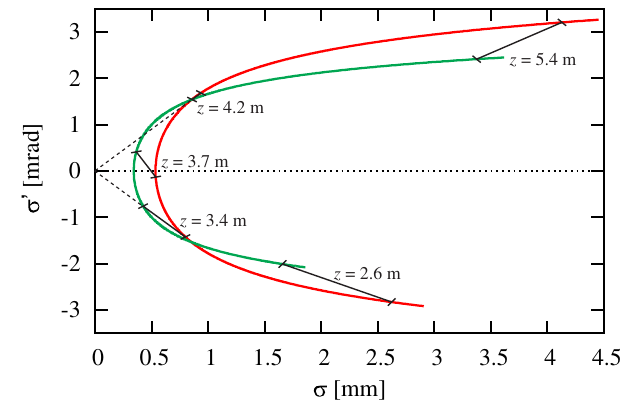
FIG. 8. Divergence versus beam size during the emittance compensation process. The high perveance slice (red curve) exhibits greater excursions in beam size and divergence than the low perveance slice (green curve). Black lines connect points which correspond to the same longitudinal position — marked in Fig. 7 — and thus indicate the development in time. At z ¼ 3 . 4 m and z ¼ 4 . 2 m, the extensions of the connecting lines (broken) cross the origin of the coordinate system; i.e., the slices are aligned. The shorter length of the connecting line at z ¼ 4 . 2 m corresponds to a smaller emittance contribution due to the beam size